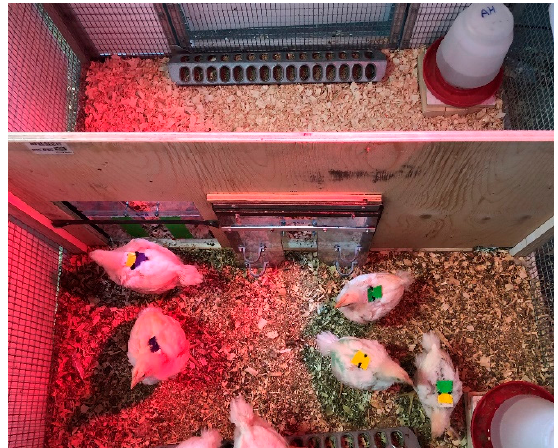
Figure 1. Image of broiler chick floor pens with heat lamps on. Each pen contained an H (bottom) and T (top) compartment separated by a wooden barrier with two unidirectional polycarbonate push doors. H and T alternated sides daily. The unidirectional push doors are lowered in this image. Weights could be added to the doors, which was only done for the door leading to the T compartment. Water and feed were available in both compartments except during the feed treatment.